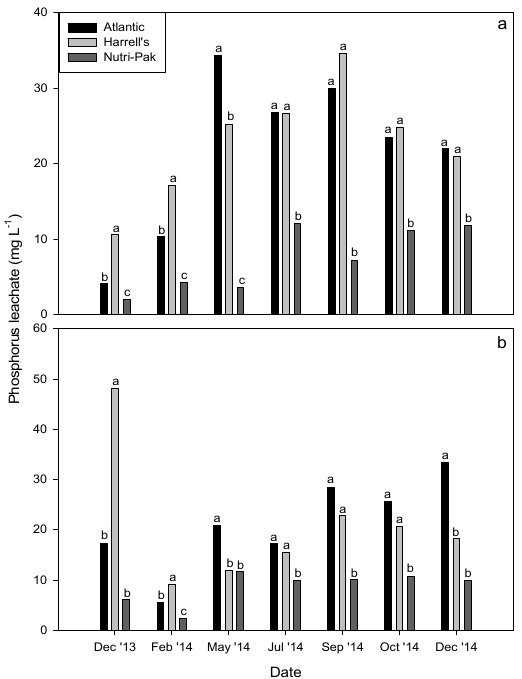
Figure 3. Phosphorus leached from potting medium Livistona chinensis ( a ) and Syagrus romanzoffiana ( b ) plants during 17 months of growth with Atlantic, Harrell’s or Nutri-Pak fertilizer. Letters above bars for an individual date represent mean separation by Tukey’s at 0.05 level.